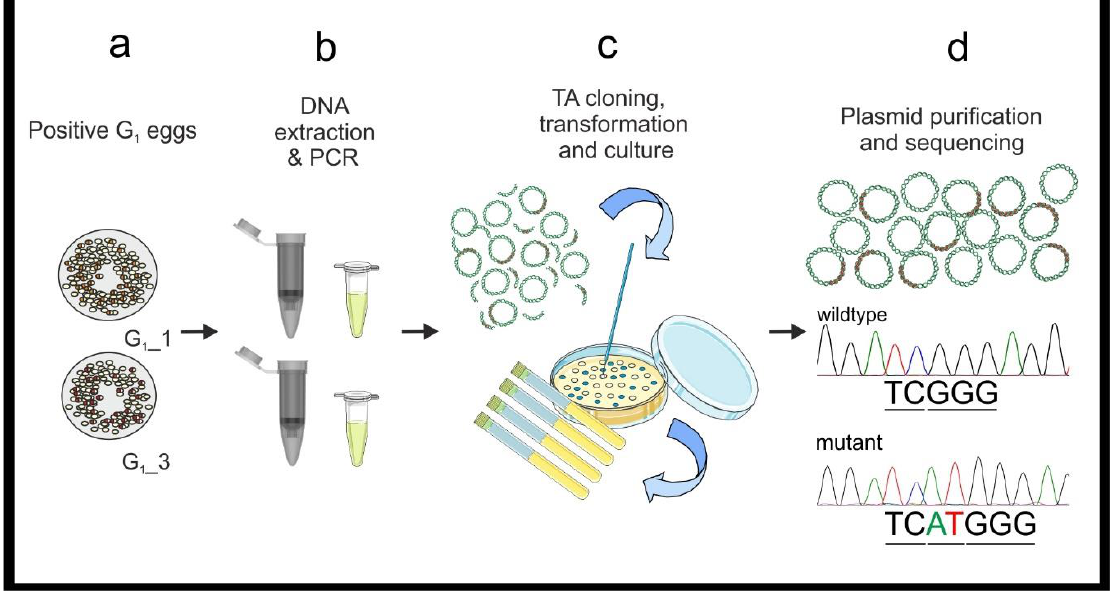
Figure 3. A workflow for mutation determination. ( a , b ) DNA extraction and PCR are performed on individual eggs from egg batches bearing a mutation. ( c ) The PCR fragments are cloned in plasmids for sequencing. ( d ) Plasmids are purified, and specific DNA sequences are determined with Sanger sequencing. The precise mutation sequence is used to design ARMS-PCR primers.